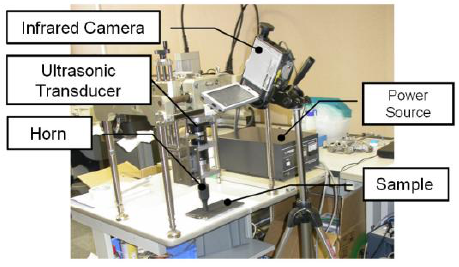
Figure 11. Experimental set-up of ultrasonic stimulated thermography, from [98].